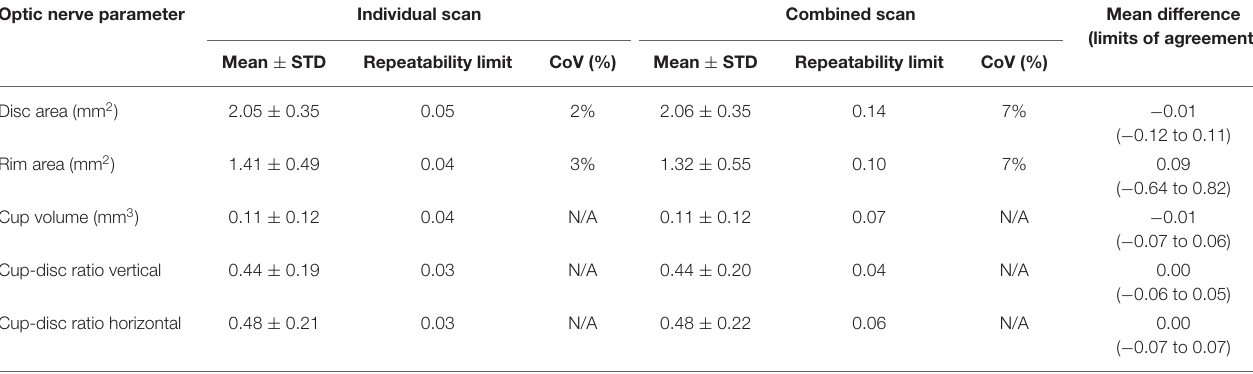
TABLE 5 | Optic nerve parameters with two scan modes, and the repeatability, and agreement results. Optic nerve